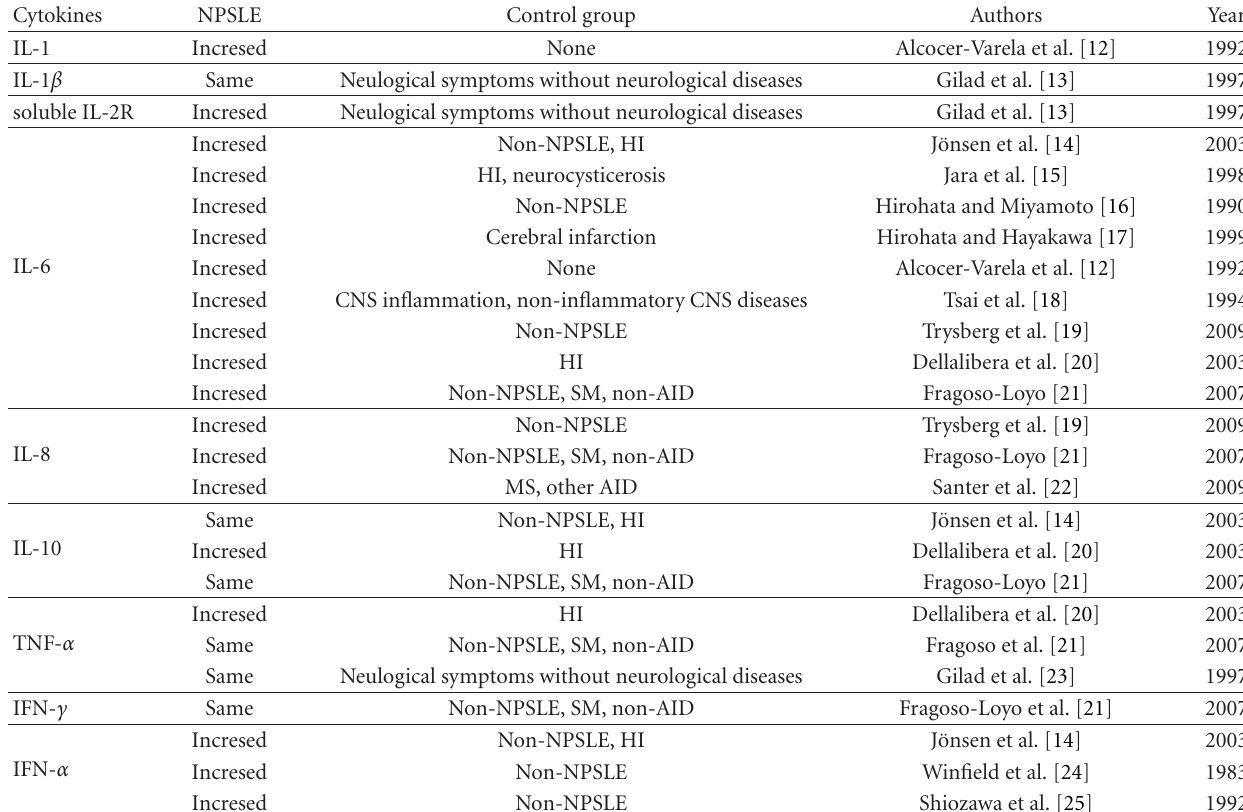
Table 1: Cytokines in CSF of